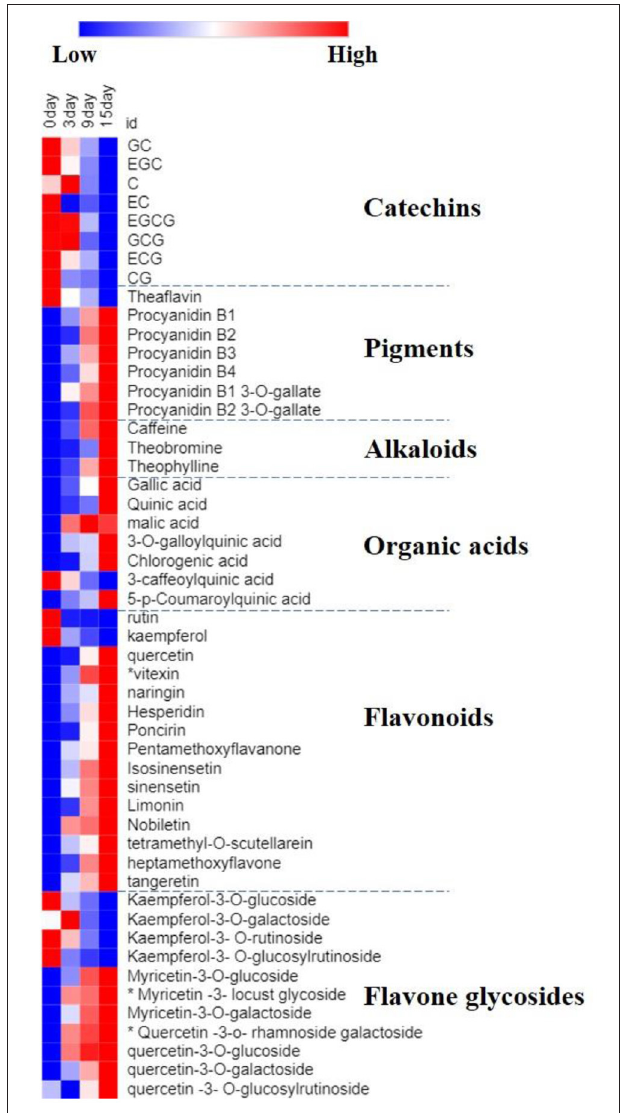
FIGURE 3 | Heatmap analysis of potential flavor compounds from Ganpu